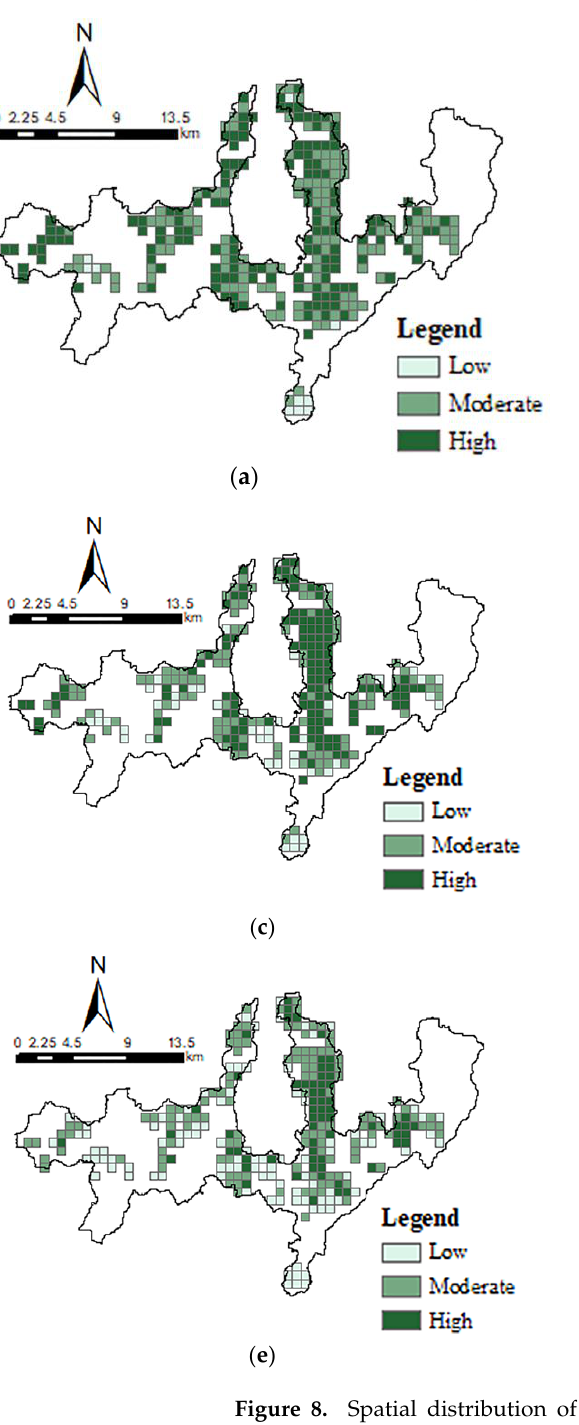
landscape-fragmentation index and CONTAG, ( e ) woodland landscape-fragmentation index and LSI, and ( f ) biological reserve landscape-fragmentation index and LSI.